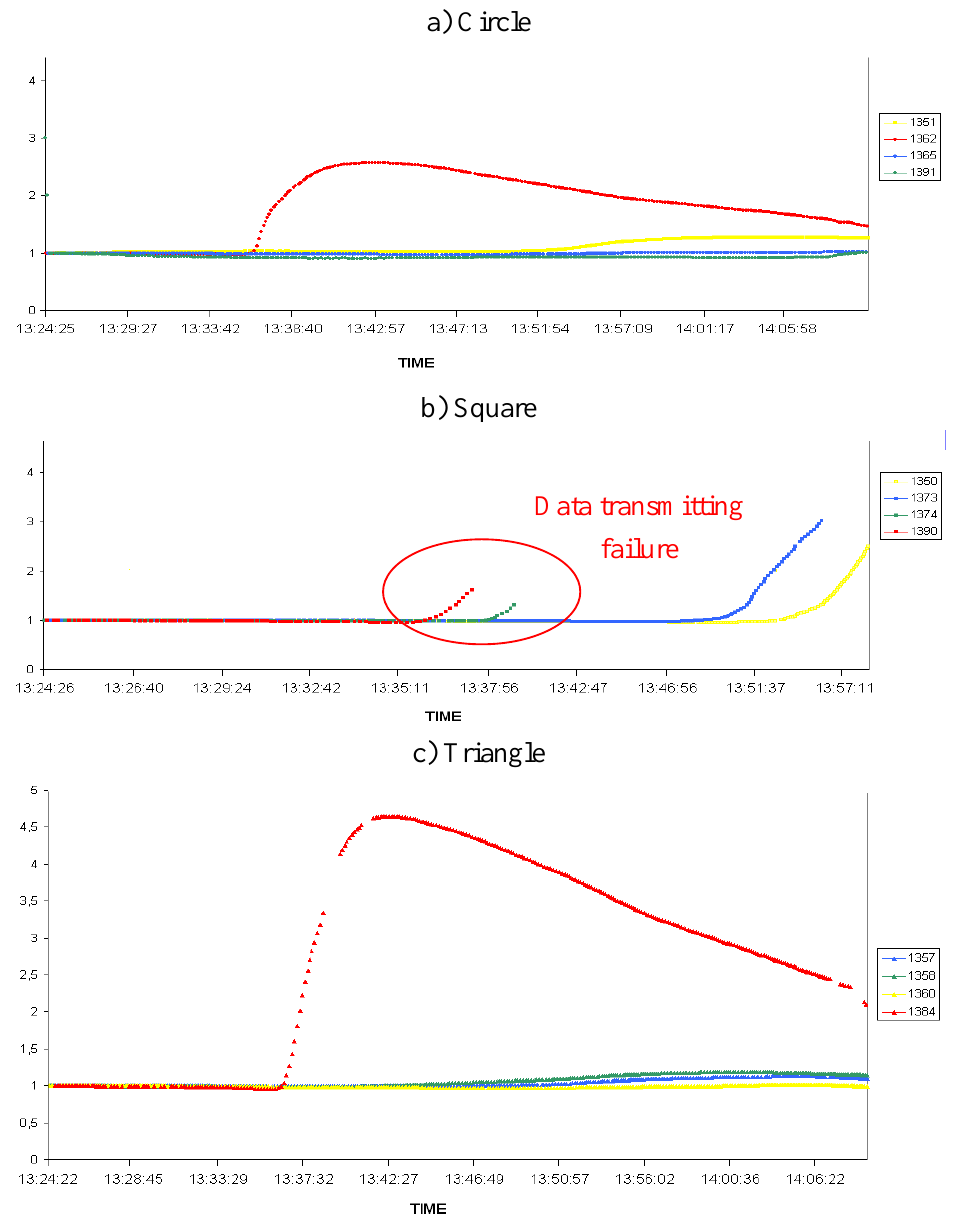
Figure 8. Temperature results of the 12 MICA2 3 rd